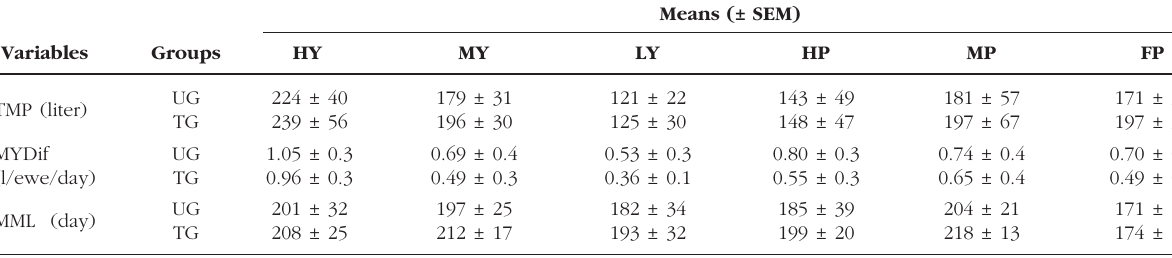
Table III. – Mean (± SEM) total milk production (TMP), January-March difference in milk yield (MYDif) and machine-milking period length (MML) for levamisole treated (TG) and untreated (UG) groups, blocked by ewe milk yield level (high yield level: HY; medium yield level: MY; low yield level: LY) and ewe parity (sixth or more parities: HP; second up to fifth parities: MP; first parity: